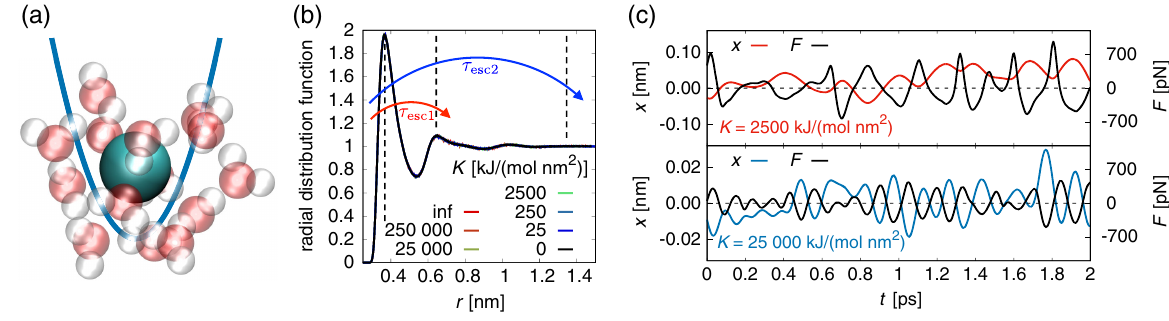
FIG. 1. Simulation setup. (a) A single methane is solvated in water and confined in an external harmonic potential of strength K . (b) Radial distribution functions (RDF) of the separation between methane and water oxygens for box size L ¼ 4 . 5 nm and different K including the frozen limit K ¼ ∞ , all curves perfectly superimpose. The positions of the first two maxima, used to calculate the mean escape time τ , and the positions used to calculate the mean escape time τ , are indicated by vertical dashed lines. (c) Methane esc 1 esc 2 position x ð t Þ and total force F ð t Þ trajectories for two different K values. Fig. 2(b) for large t reflect the friction coefficient γ .